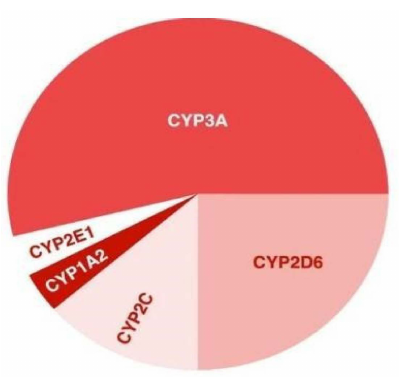
Figure A2. Antipsychotic metabolism phases [49].